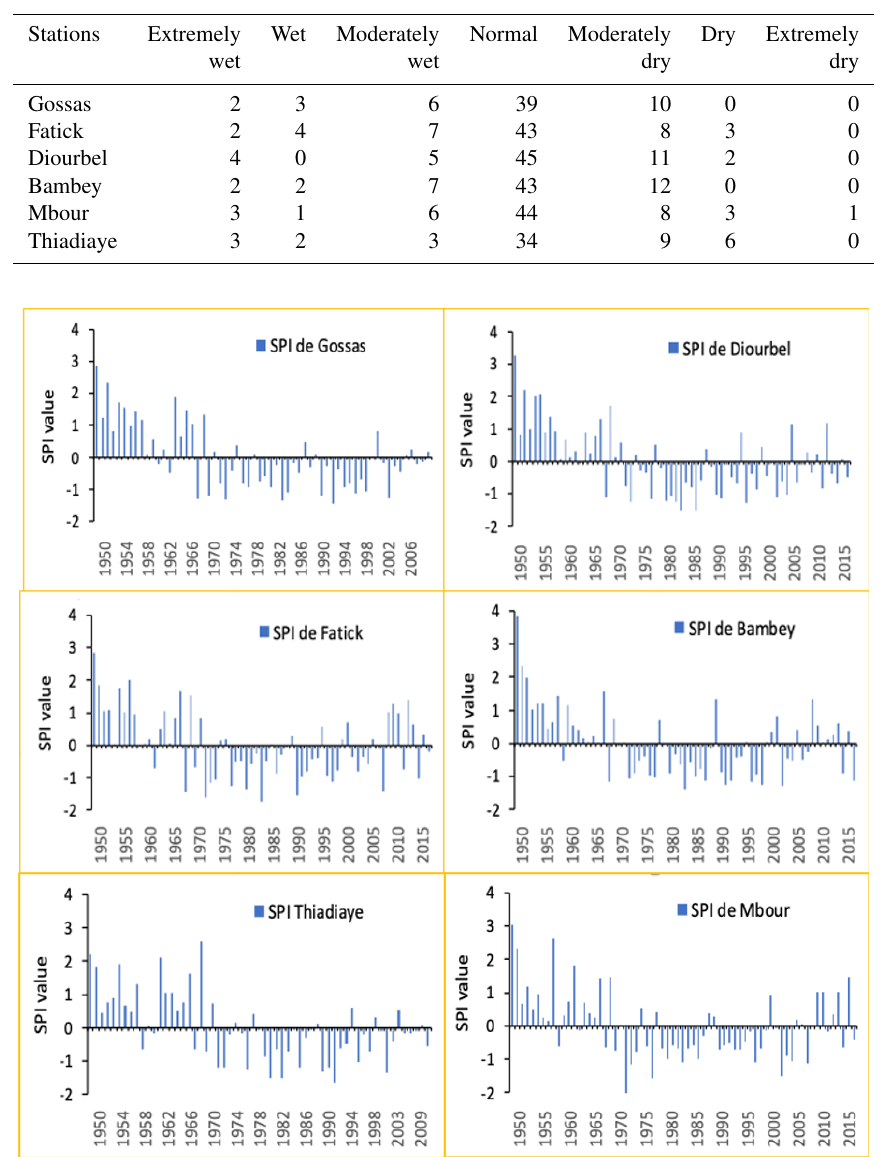
Table 2. Rainfall anomalies for the studied stations from 1950 to 2009 for Gossas, from 1950 to 2011 for Thiadiaye, and from 1950 to 2016 for Bambey, Fatick, Diourbel and Mbour.